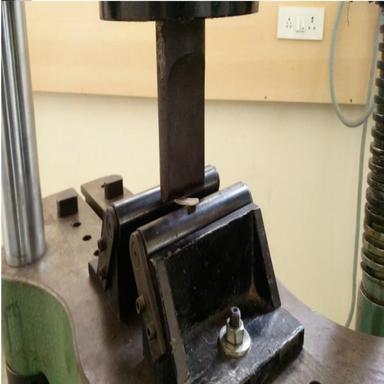
Flexural Test experimental setup.